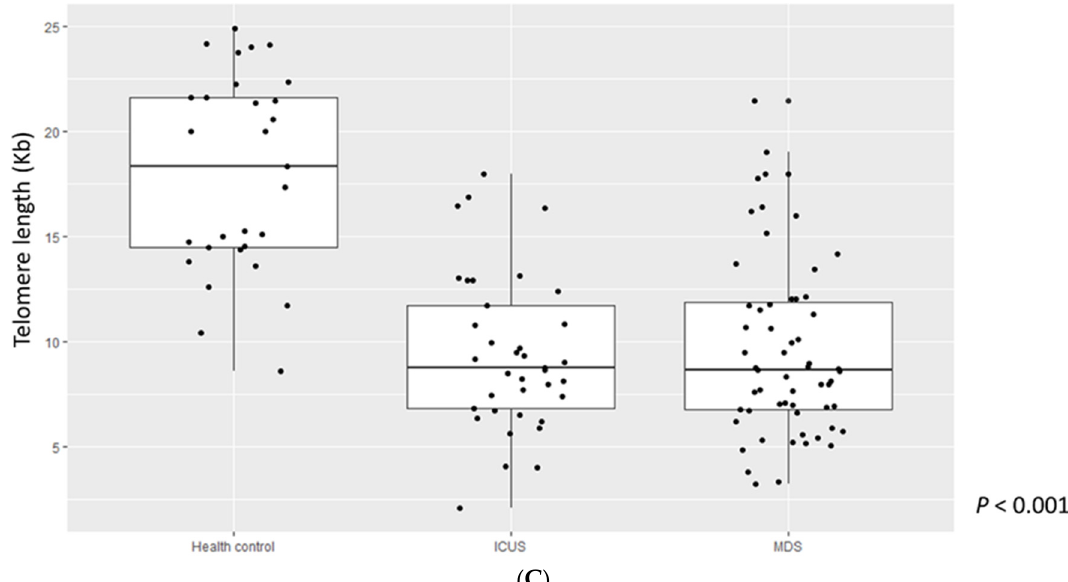
Figure 1. ( A ) Cleave caspase-3 grade in patients with MDS, ICUS, HCs. Abbreviation: MDS, myelodysplastic syndrome; ICUS, Idiopathic cytopenia of undetermined significance; HCs, Health controls. ( B ) Ki-67 grade in patients with MDS, ICUS, HCs. Abbreviation: MDS, myelodysplastic syndrome; ICUS, Idiopathic cytopenia of undetermined significance; HCs, Health controls. ( C ) Telomere length in patients with MDS, ICUS, HCs. Abbreviation: MDS, myelodysplastic syndrome; ICUS, Idiopathic cytopenia of undetermined significance; HCs, Health controls.